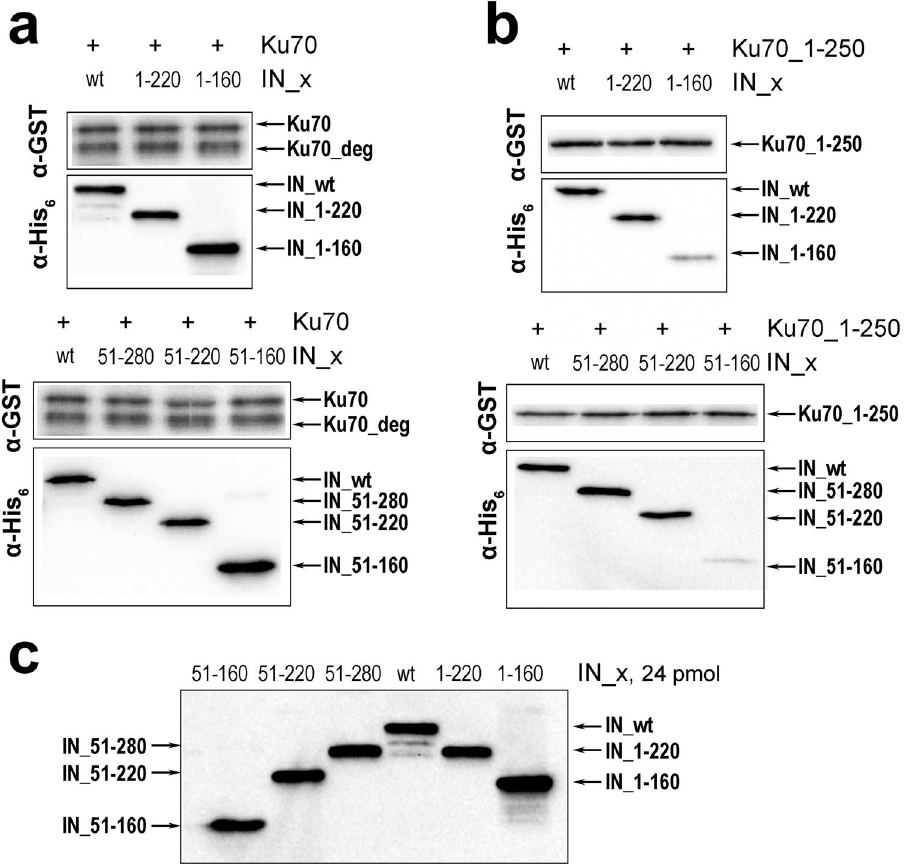
Figure 4. GST-pull down assay analysis of the binding of IN_wt and a series of its deletion mutants (200 nM) with full-length Ku70 (100 nM) containing a major degradation product (1–318 а.а.) ( a ) and with its truncated mutant Ku70_1-250 (100 nM) ( b ). Western blot analysis of the same amount (24 pmol) of different truncated IN mutants with anti-His 6 antibody (c)